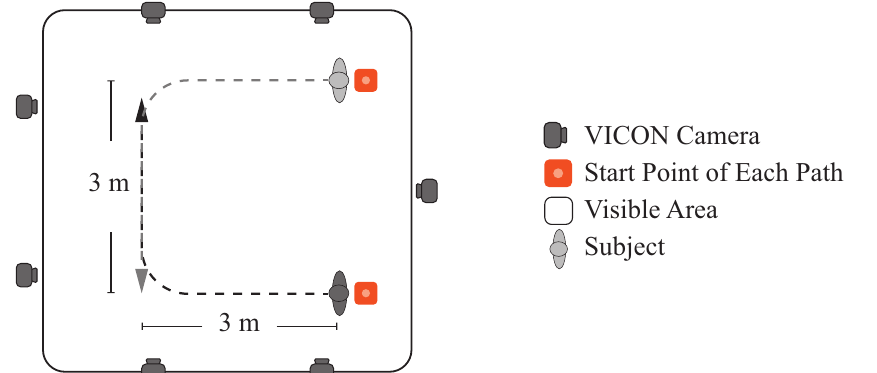
Figure 4. Reference paths for the experimental trials in the motion analysis laboratory. The area that the cameras were able to capture was 6 × 6 m 2